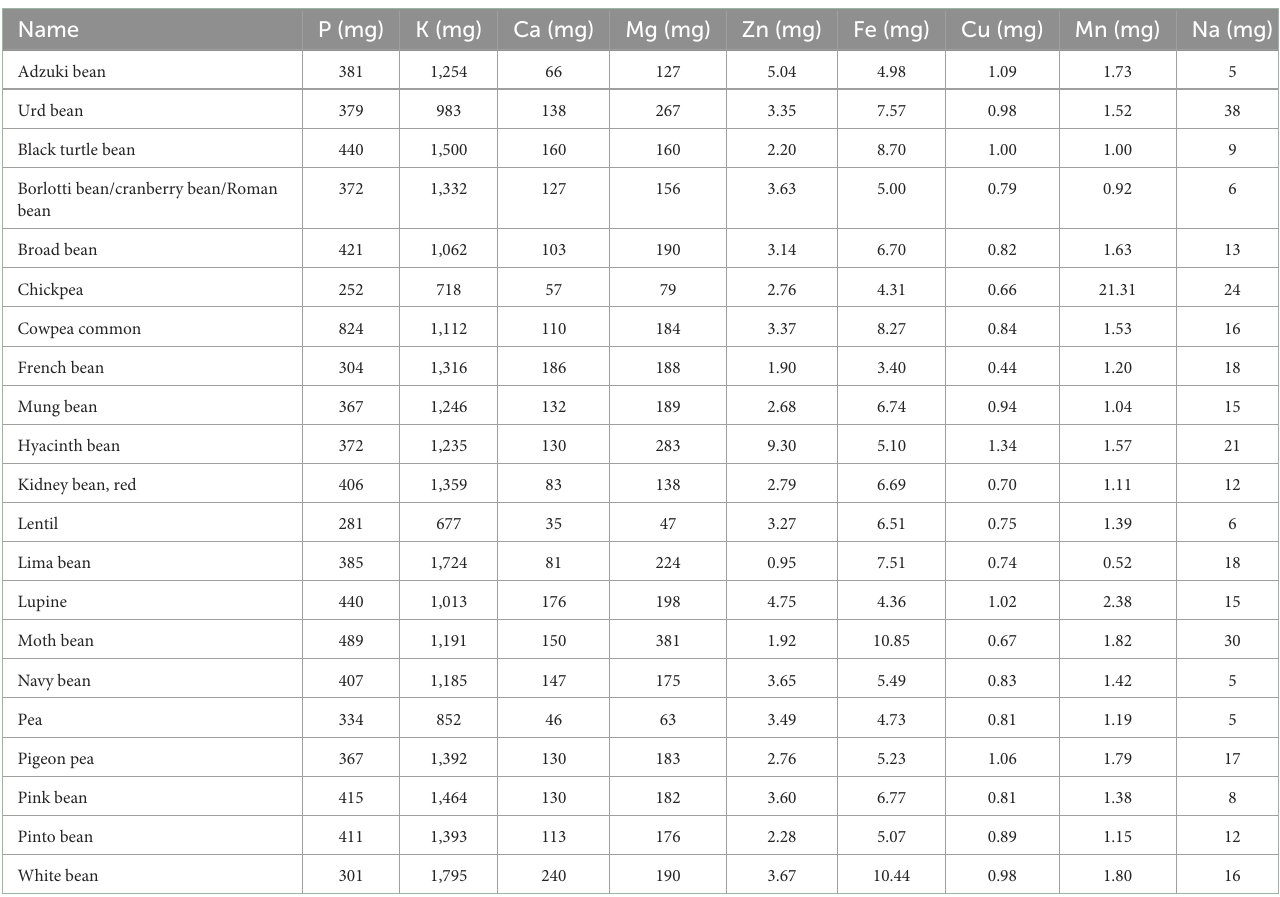
TABLE 5 Mineral profile of common pulses ( https://www.nutritionvalue.org